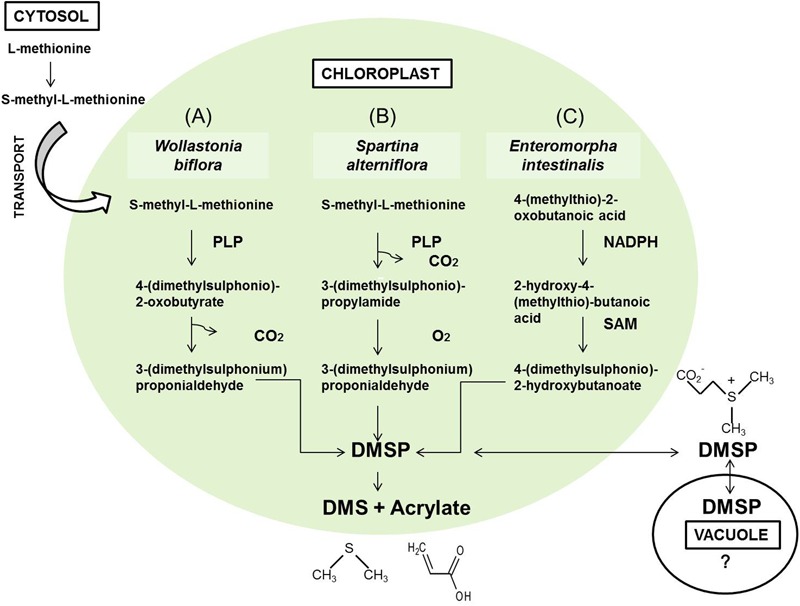
Biosynthetic pathways of DMSP in Wollastonia biflora(A), Spartina alterniflora(B) (Trossat et al., 1996), and Enteromorpha intestinalis(C) (Summers et al., 1998).